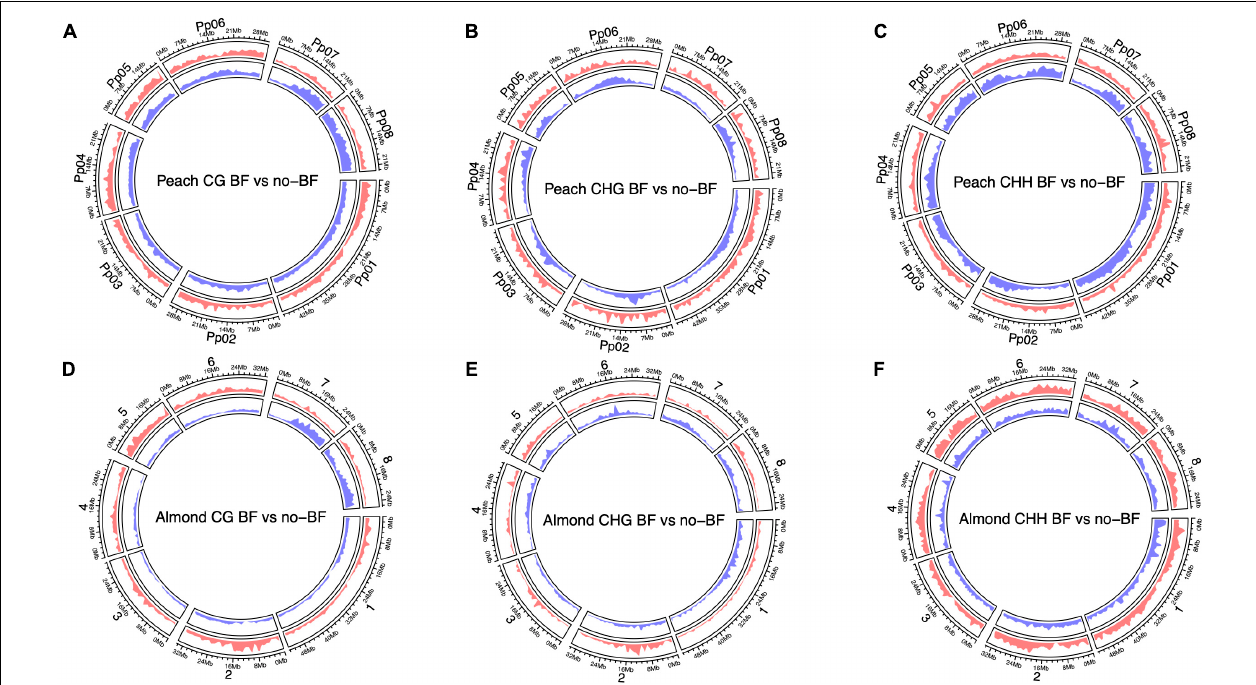
FIGURE 2 | Circos plots displaying genome-wide differential methylation between NBF and no-NBF hybrids in each methylation context [CG, CHG, CHH (H = A, T, or C)] using both the almond and peach reference genomes. (A–C) Show differential methylation based on alignment to the peach genome for each methylation context. The red circle represents hypermethylation in the NBF hybrids compared to the no-NBF hybrids, and the blue circle represents hypomethylation in the NBF hybrids compared to the no-NBF hybrids. (D–F) Show differential methylation based on alignment to the almond genome with hypermethylation and hypomethylation displayed as described above. The y -axis represents genomic density defined as the fraction of a genomic window that is covered by a genomic region (in this case, a